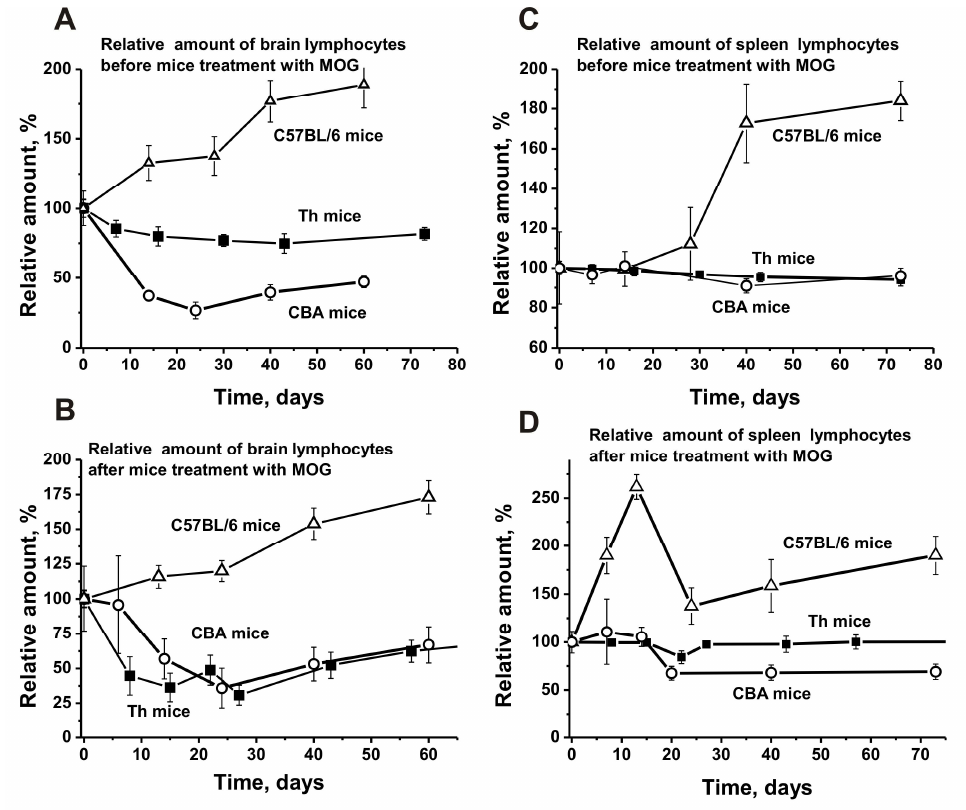
Figure 5. The average changes over time in the relative number of lymphocytes before and after treatment with MOG in the bone marrow ( A,B ) and spleen ( C,D ) of C57BL / 6, CBA, and Th mice. First, the number of lymphocytes was estimated from optical density for each mouse and all groups (with seven mice per group); the error from three independent experiments did not exceed 7%–10%. Then the relative number of lymphocytes (optical density) before immunization at time zero of the experiment was taken as 100%.